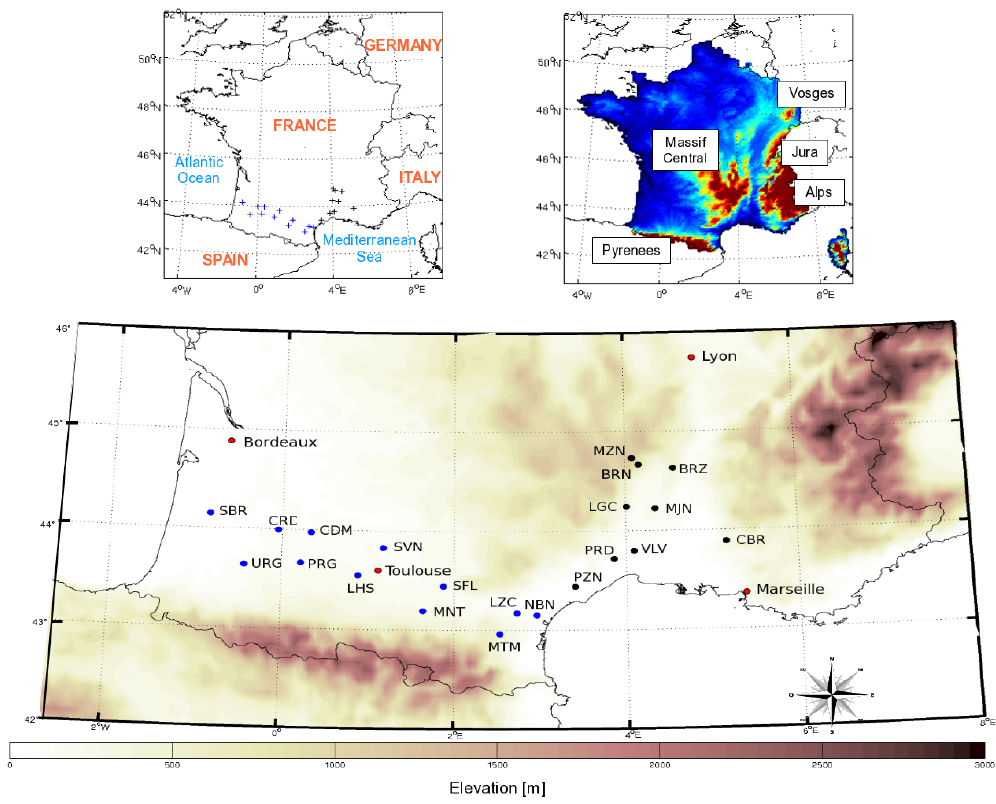
Fig. 1. The SMOSMANIA soil moisture network in southern France. The blue dots and crosses represent the 12 stations operational since 2007, the dark dots and crosses represent the new 9 stations operational since 2009. Topography is shown (bottom, top-right panel) together with the main mountainous areas (top-right).